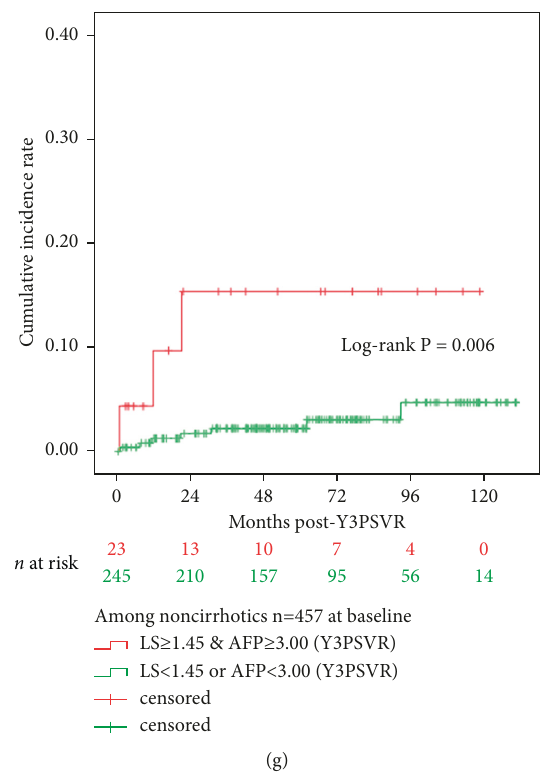
Figure 3: Kaplan–Meier survival analysis for predicting LREs from the baseline of Y3 post-SVR. (a) LREs ( n cirrhosis (TW0); (b) LREs ( n 14), stratified by LS (Y3PSVR); (c) LREs ( n (cid:31) concurrent LS and AFP (Y3PSVR), pairwise log-rank P ’s were significant only in classes